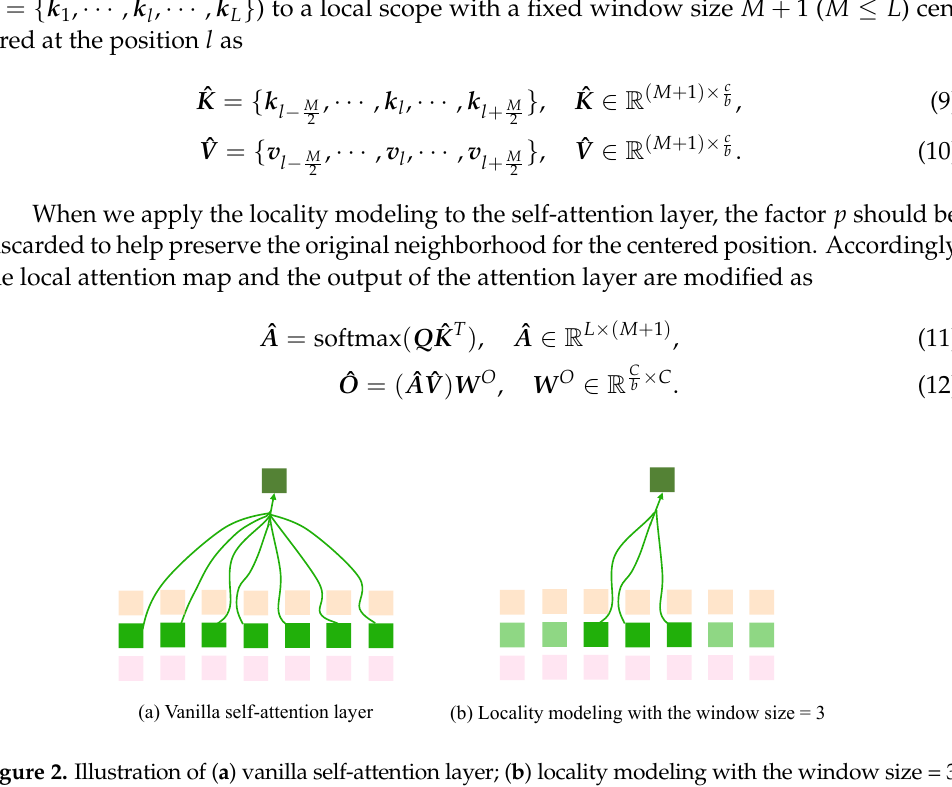
Figure 2. Illustration of ( a ) vanilla self-attention layer; ( b ) locality modeling with the window size = 3. Semi-transparent colors represent masked tokens that are invisible to the self-attention